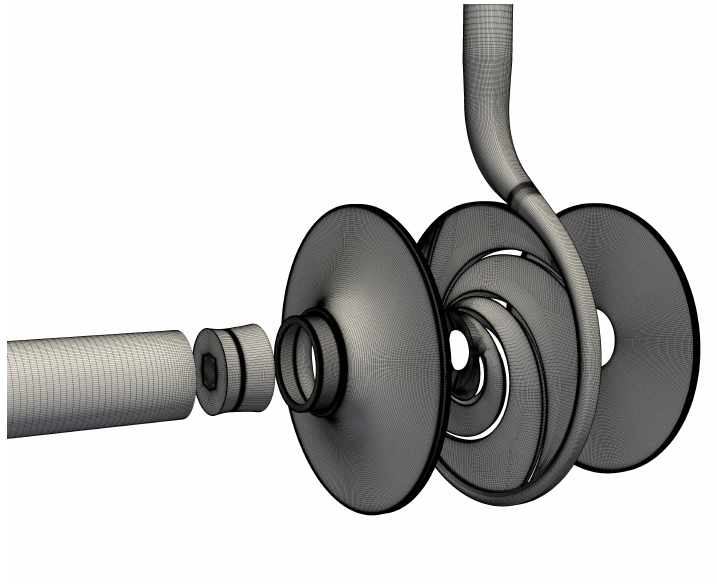
Figure 4. View of the grid for Case